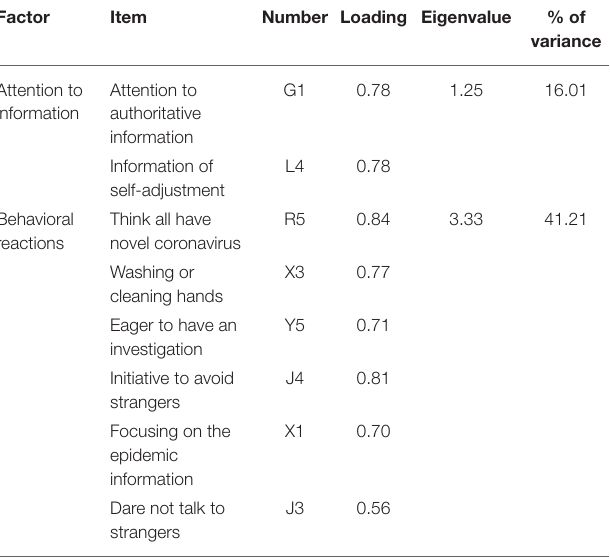
TABLE 3 | Items loadings, eigenvalues and variance of the BRS with PCA.